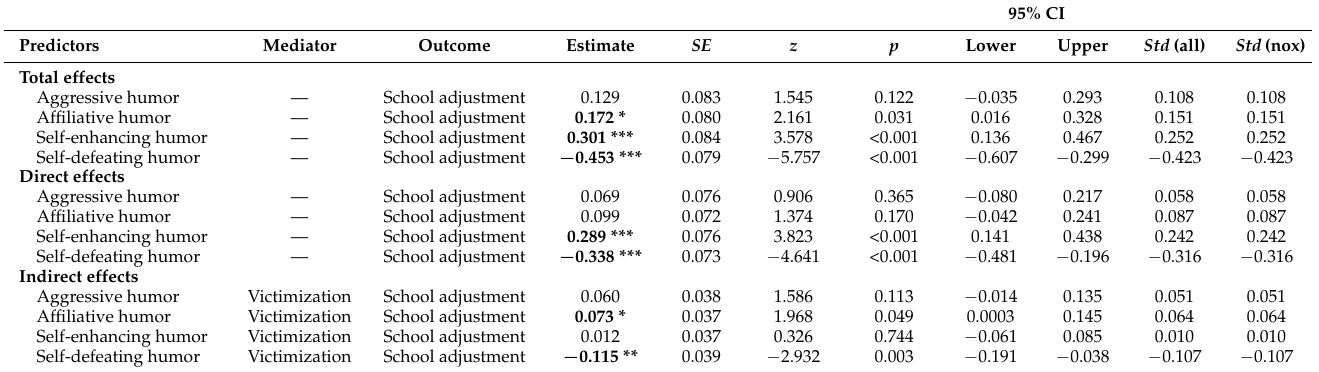
Figure 2. Mediation model: The effect of humor styles on psychological school adjustment with bullying victimization as the mediator variable. Note. Mediation analysis was calculated with JASP [51]. Only significant paths and loadings ( p ≤ 0.05) are presented. Loadings are unstandardized coefficients with standardized coefficients in parentheses. Table 2. Total, direct, total indirect and indirect effects of the model with victimization mediating the association between humor styles and psychological school adjustment. 95% CI